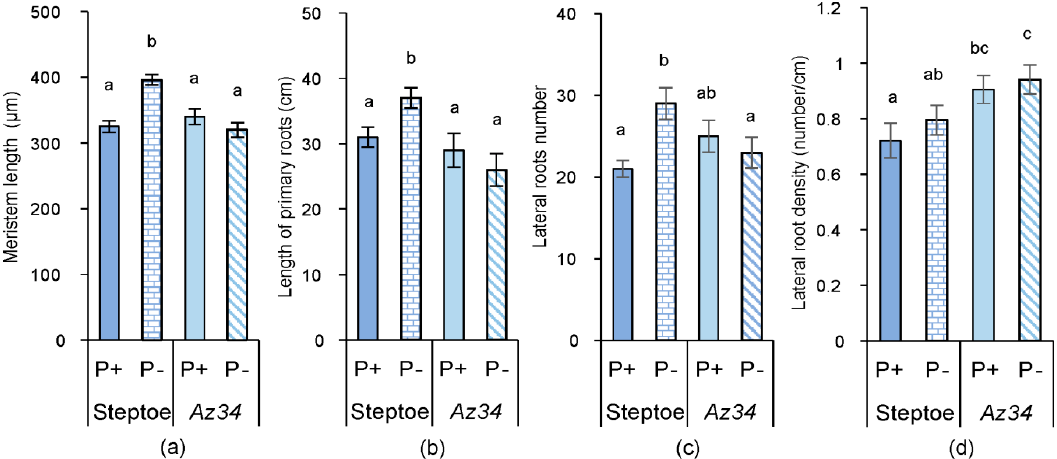
Figure 2. Root characteristics of WT (cv. Steptoe) and Az34 plants grown on nutrient solutions with (P+) or without (P − ) phosphate: meristem size measured in 4-days old plants 1 day after the start of P-treatment ( a ), the total length of all primary roots ( b ), number of lateral roots ( c ), lateral root density ( d ) measured in 7-days-old plants 4 days after the start of P-treatment. Bars are means ± S.E. of n = 20, with significant ( p ≤ 0.05) differences between all genotype/treatment combinations marked with different letters (ANOVA, LSD).